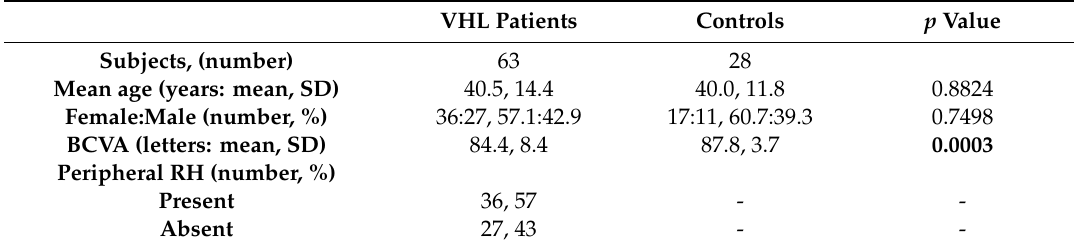
Table 1. Demographic characteristics of enrolled von Hippel-Lindau patients and healthy controls. VHL Patients Controls p